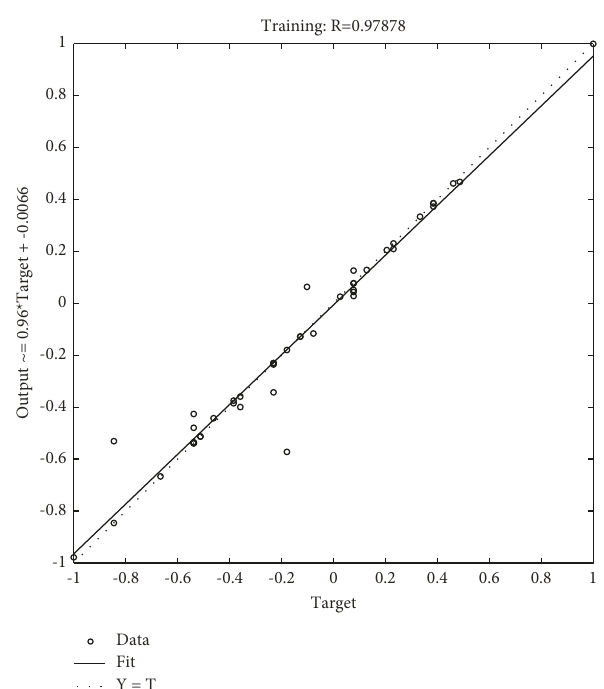
Figure 10: Accuracy of neural network training for scenario (4).